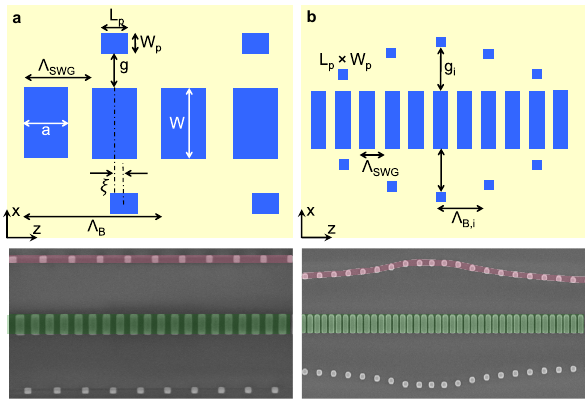
Figure 15: (a) Bragg filter with SWG metamaterial core and lateral silicon loading segments [28, 111], (b) Complex Bragg fi lter with arbitrary spectral response, composed of an SWG core with apodized lateral silicon loading segments